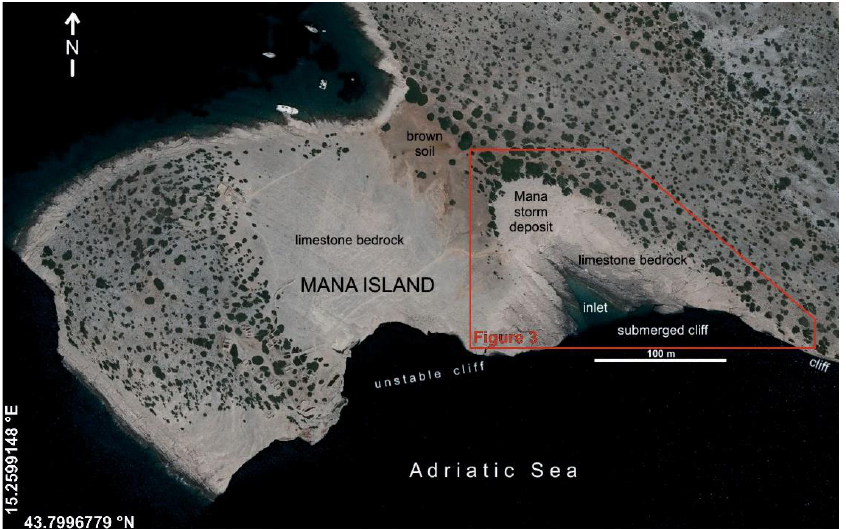
Figure 2. Low-resolution orthophoto image of the SW part of the island of Mana from 2016 (https://geoportal.dgu.hr/ accessed on 8 January 2022), and the notations showing the Mana storm deposit that unconformably overlays Upper Cretaceous limestone bedrock and Quaternary brown soil (NP Kornati, Central Adriatic, Croatia).